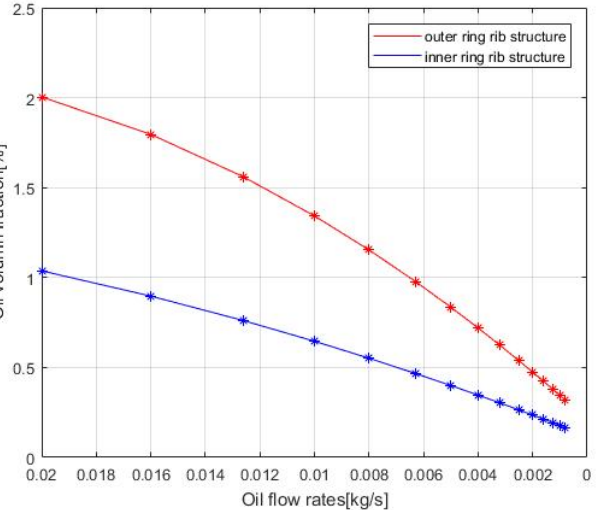
Figure 20. Changes in the volume fraction of lubricating oil in the bearing cavity during oil loss.